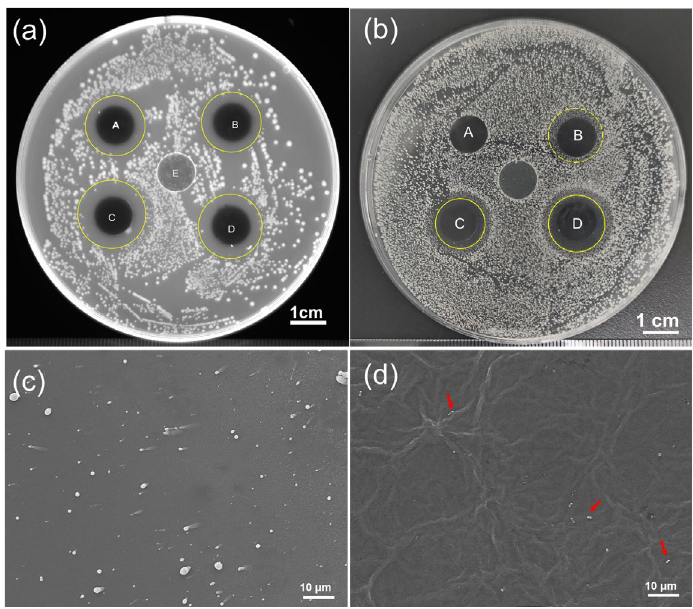
Figure 6. ( a ) The bacteriostatic effect of the GO/PNF/AgNP hybrid membrane on E. coli . ( b ) The bacteriostatic effect of the GO/PNF/AgNP hybrid membrane on S. aureus (A–D: the content of AgNO 3 in the hybrid membrane is 15, 25, 50, and 75 μL, respectively; E: blank SEM film without the hybrid membrane) after the attachment experiment. ( c ) Blank silicon wafer and ( d ) silicon wafer covered with the hybrid film.